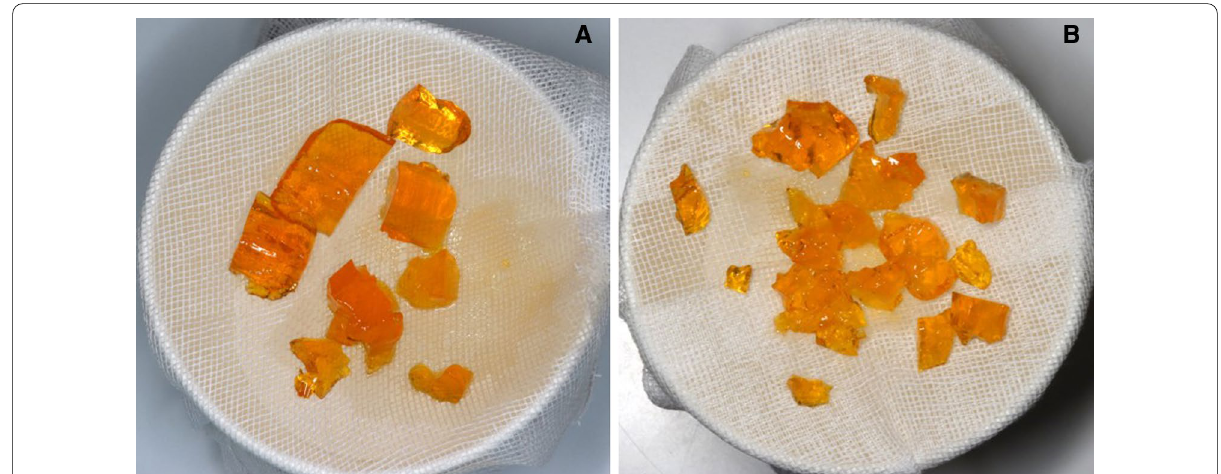
Fig. 10 Masticatory performance examination before ( a ) and after ( b ) prosthetic treatment